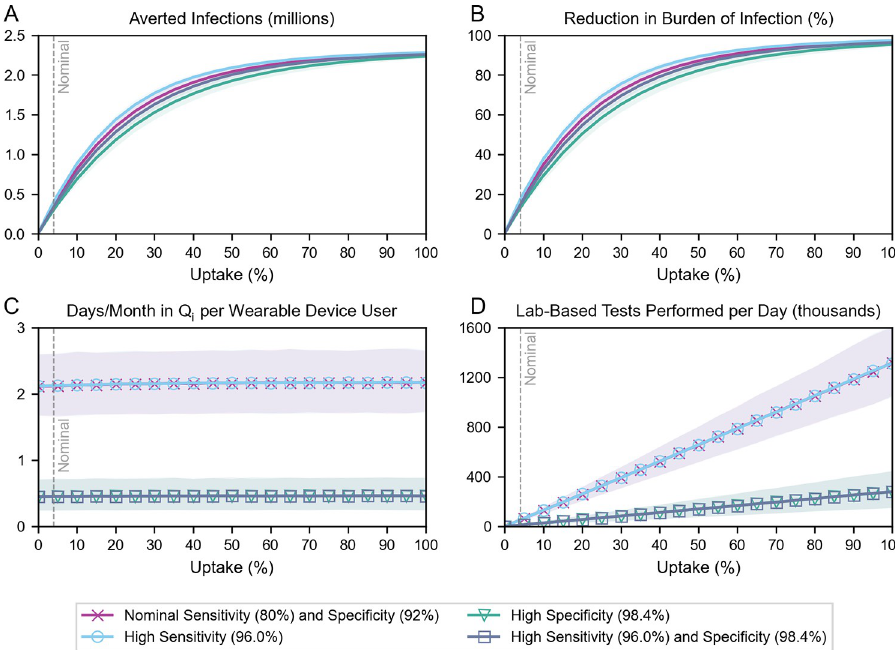
Fig 4. Impact of increasing uptake under different technology assumptions. (A) Averted infections, (B) reduction in the burden of infection, (C) days incorrectly spent in quarantine per month per user, and (D) average daily demand for lab-based tests, all over the simulation period, as a function of increasing uptake. Grey dashed lines denote nominal uptake (4%). In the “High Sensitivity” and “High Specificity” scenarios, detection specificity and sensitivity are kept at their nominal values, respectively. Symbol markers are added in (C) and (D) to distinguish overlapping curves: in these charts, the “Nominal Sensitivity and Specificity” and “High Sensitivity” curves overlap, and the “High Specificity” and “High Sensitivity and Specificity” curves